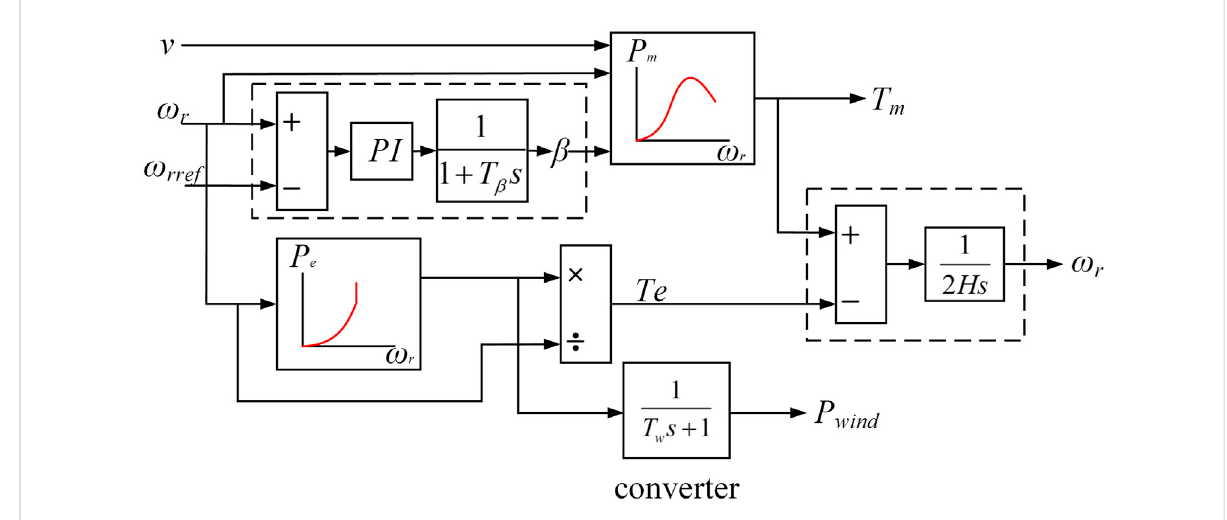
FIGURE 4 Overall simpli fi ed structure diagram of the wind turbine integrates the modules in Figure 3 to combine the overall simpli fi ed model structure of the wind